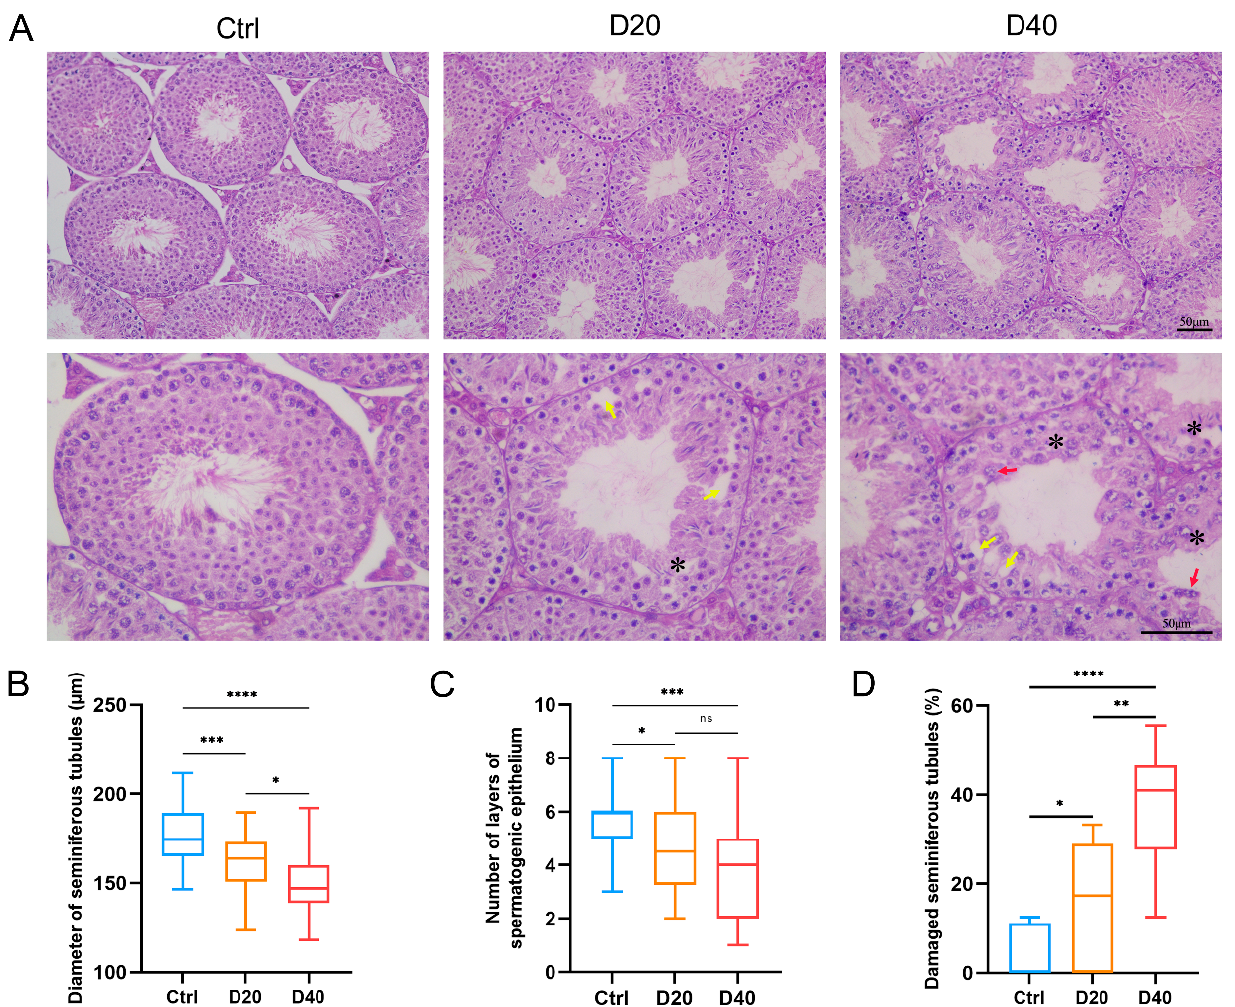
Figure 2. DFZ exposure leads to pathological changes in testicular tissue. ( A ) H&E staining of testicular tissue (black markers indicate the disrupted germinal epithelium. Yellow arrows indicate the vacuolation of the germinal epithelium. Red arrows indicate the sloughing of germ cells. Asterisk indicates damaged seminiferous tubules), ( B ) diameter of seminiferous tubules, ( C ) number of spermatogenic epithelium layers, and ( D ) percentage of damaged seminiferous tubules in different groups. * p < 0.05, ** p < 0.01, *** p < 0.001, **** p < 0.0001, ns. indicates not statistically significant versus the control group.